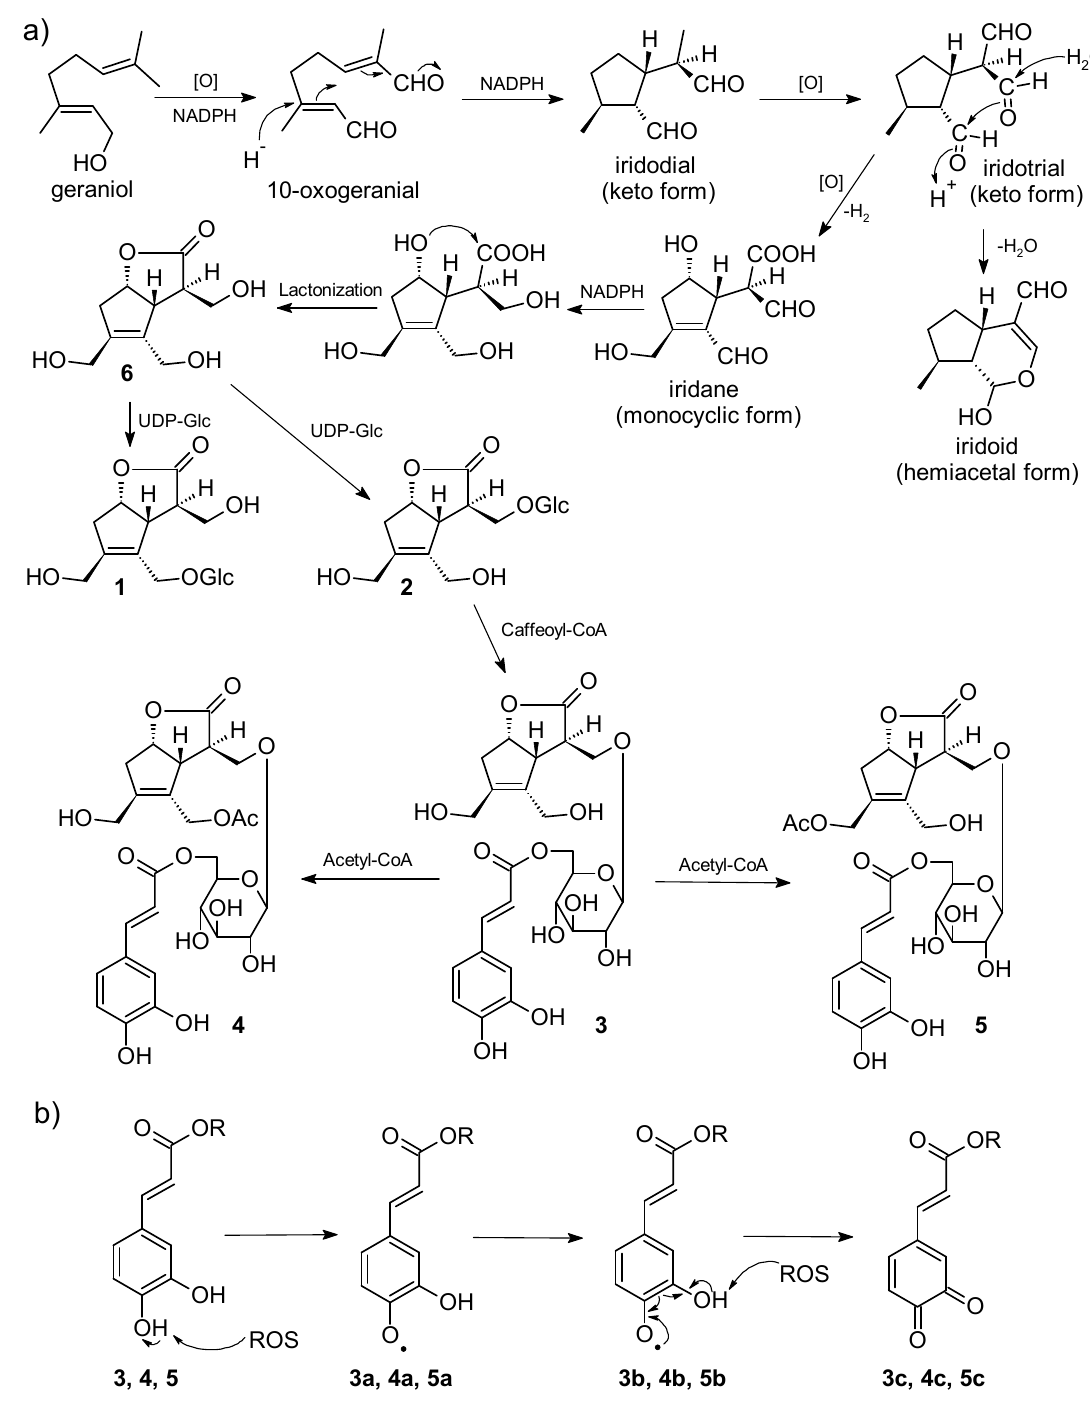
Figure 4. Plausible biosynthetic pathway of compounds 1 – 5 , and possible antioxidant mechanism of compounds 3 – 5 . ( a ) Plausible biosynthetic pathway. Iridotrial (keto form) is a common substrate for